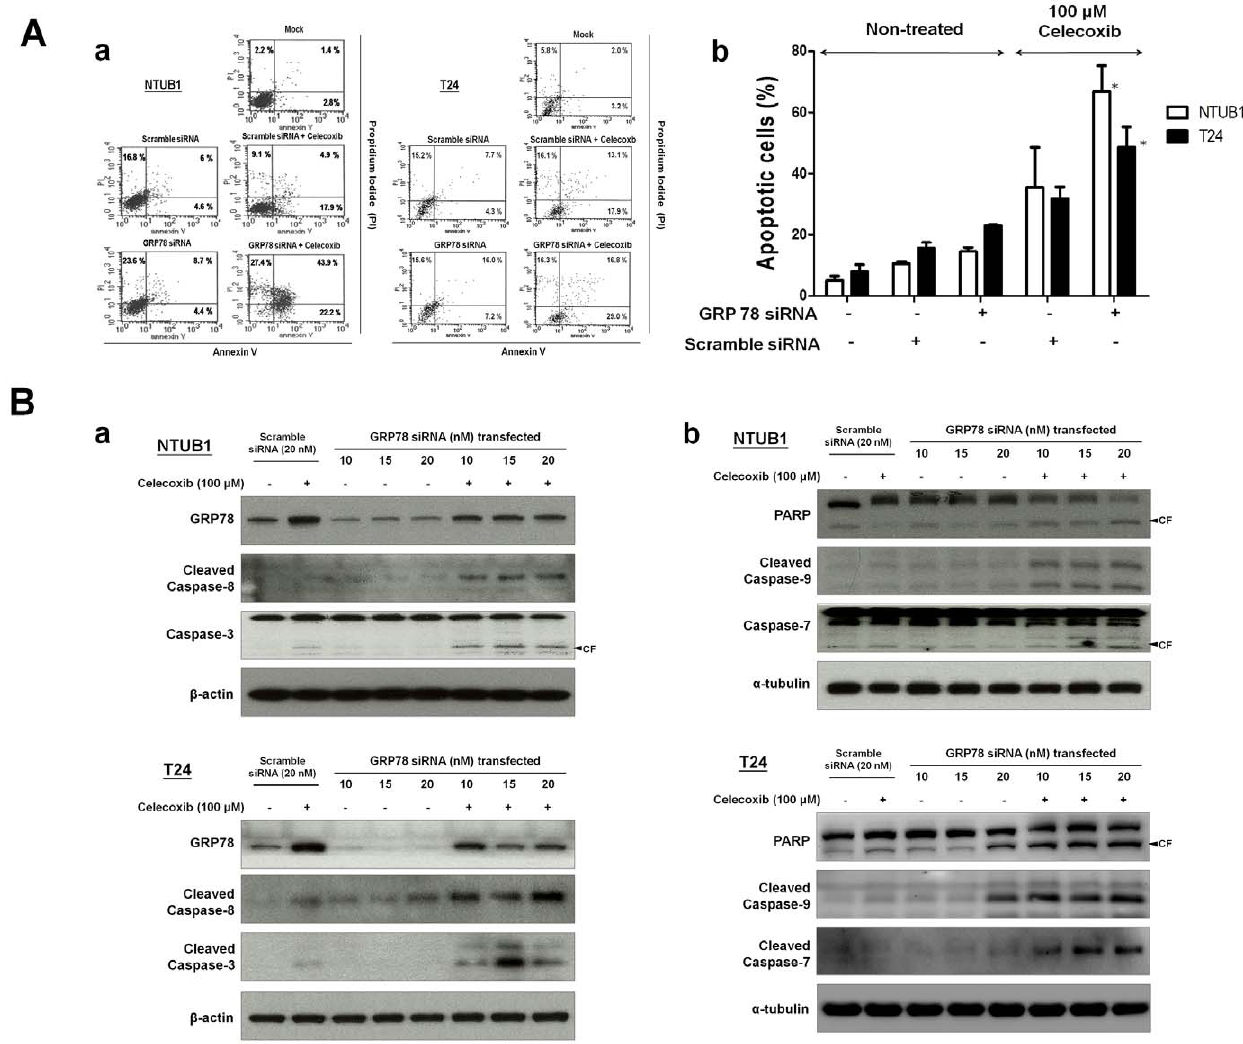
Figure 4. The combinative effects of celecoxib and GRP78 knockdown on apoptosis of NTUB1 and T24 cells. (A) Cells were transfected with GRP78 siRNA (10 nM) or scramble siRNA (10 nM) (as a control); then treated with 100 m M celecoxib. The combinative effect of celecoxib and GRP78 knockdown on apoptosis was determined by flow cytometry (FACS) with annexin V-FITC and PI labeling in (a). (b) Quantitative analysis of total apoptosis (early and late) population was presented. Data are presented as means 6 SD of three independents experiments. * p , 0.05 as compared with scramble siRNA + celecoxib. (B) Cells were transfected with 10, 15 and 20 nM GRP78 siRNA, and 20 nM scramble siRNA as control; then treated with 100 m M celecoxib. Cell lysates were harvested and analyzed by Western blotting with specific antibodies against GRP78, caspase-3, 8, cleaved caspase-3, 8 (a), caspase- 9, 7, cleaved caspase-7, 9, PARP and cleaved PARP (b). CF is the abbreviation of cleaved form. Results shown are representative of at least three independent experiments.